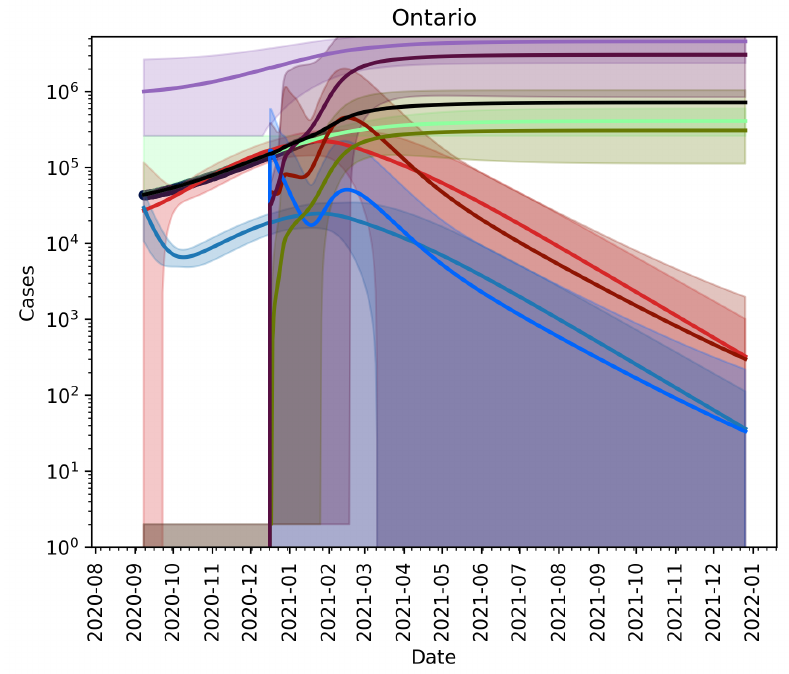
Figure 5. Figure showing the model fit with both the wildtype and mutant. Red is mild cases, blue is severe cases, green is the cumulative reported cases, and purple is the total cases. The light colours are the wildtype, and dark colours are the